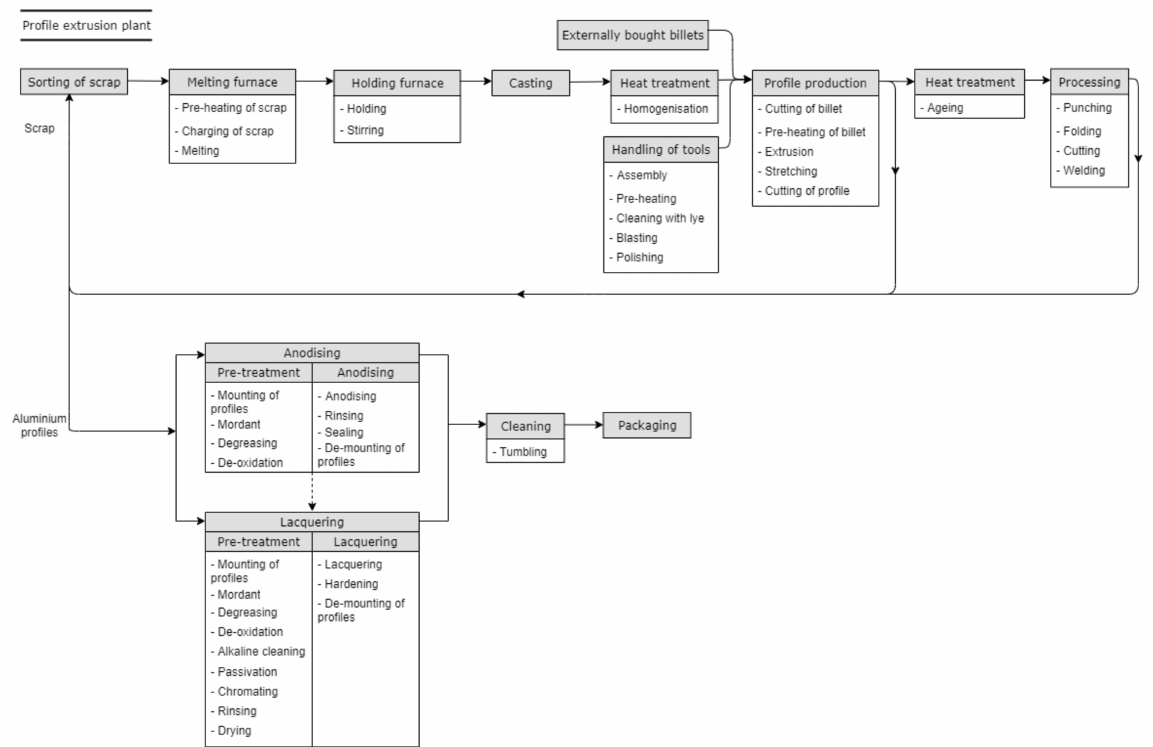
Figure 3. Production processes associated with profile extrusion